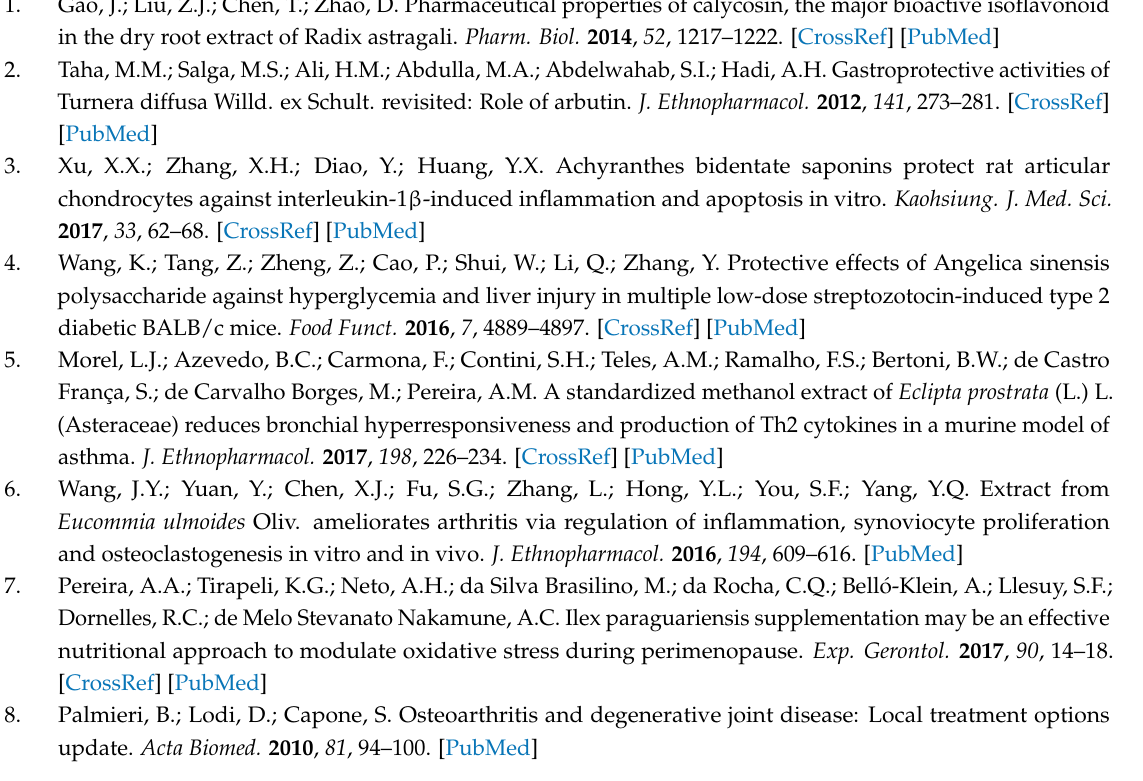
Figure S5: 13 C-NMR spectra of ( − )-marmesinin ( 2 ); Figure S6: ESI-MS spectra of ( − )-marmesinin ( 2 ); Figure S7: 1 H-NMR spectra of columbianetin β - D -glucopyranoside ( 3 ); Figure S8: 13 C-NMR spectra of columbianetin β - D -glucopyranoside ( 3 ); Figure S9: ESI-MS spectra of columbianetin β - D -glucopyranoside ( 3 ); Figure S10: 1 H-NMR spectra of isomucronulatol 7- O - β - D -glucoside ( 4 ); Figure S11: 13 C-NMR spectra of isomucronulatol 7- O - β - D -glucoside ( 4 ); Figure S12: ESI-MS spectra of isomucronulatol 7- O - β - D -glucoside ( 4 ); Figure S13: 1 H-NMR spectra of ecliptasaponin A ( 5 ); Figure S14: 13 C-NMR spectra of ecliptasaponin A ( 5 ); Figure S15: ESI-MS spectra of ecliptasaponin A ( 5